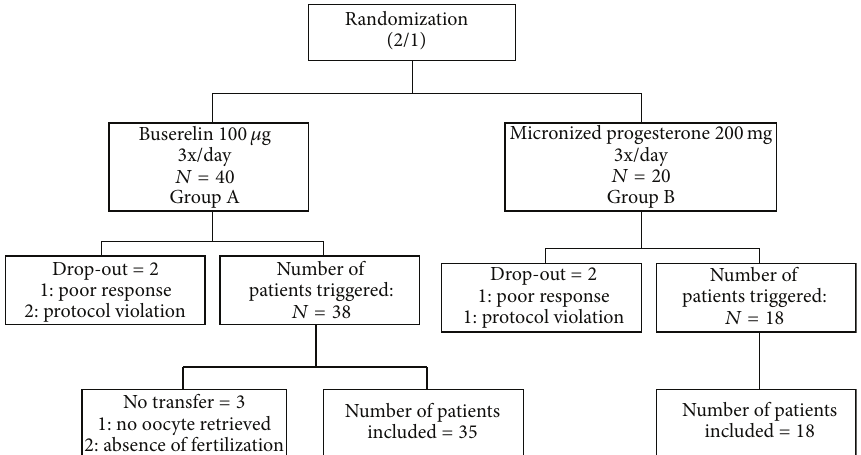
Figure 1: Randomization and allocation of patients to the two groups. In group A, ovulation was triggered with buserelin and the luteal phase was also supported by buserelin. In group B, ovulation was triggered with hCG and the luteal phase was supported with vaginal micronized